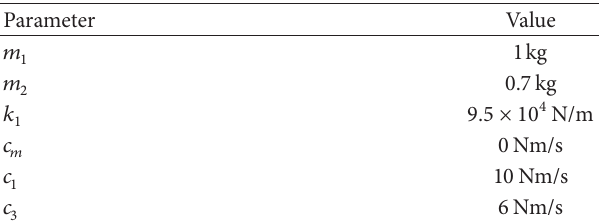
Table 3: Parameters of the rotor-absorber